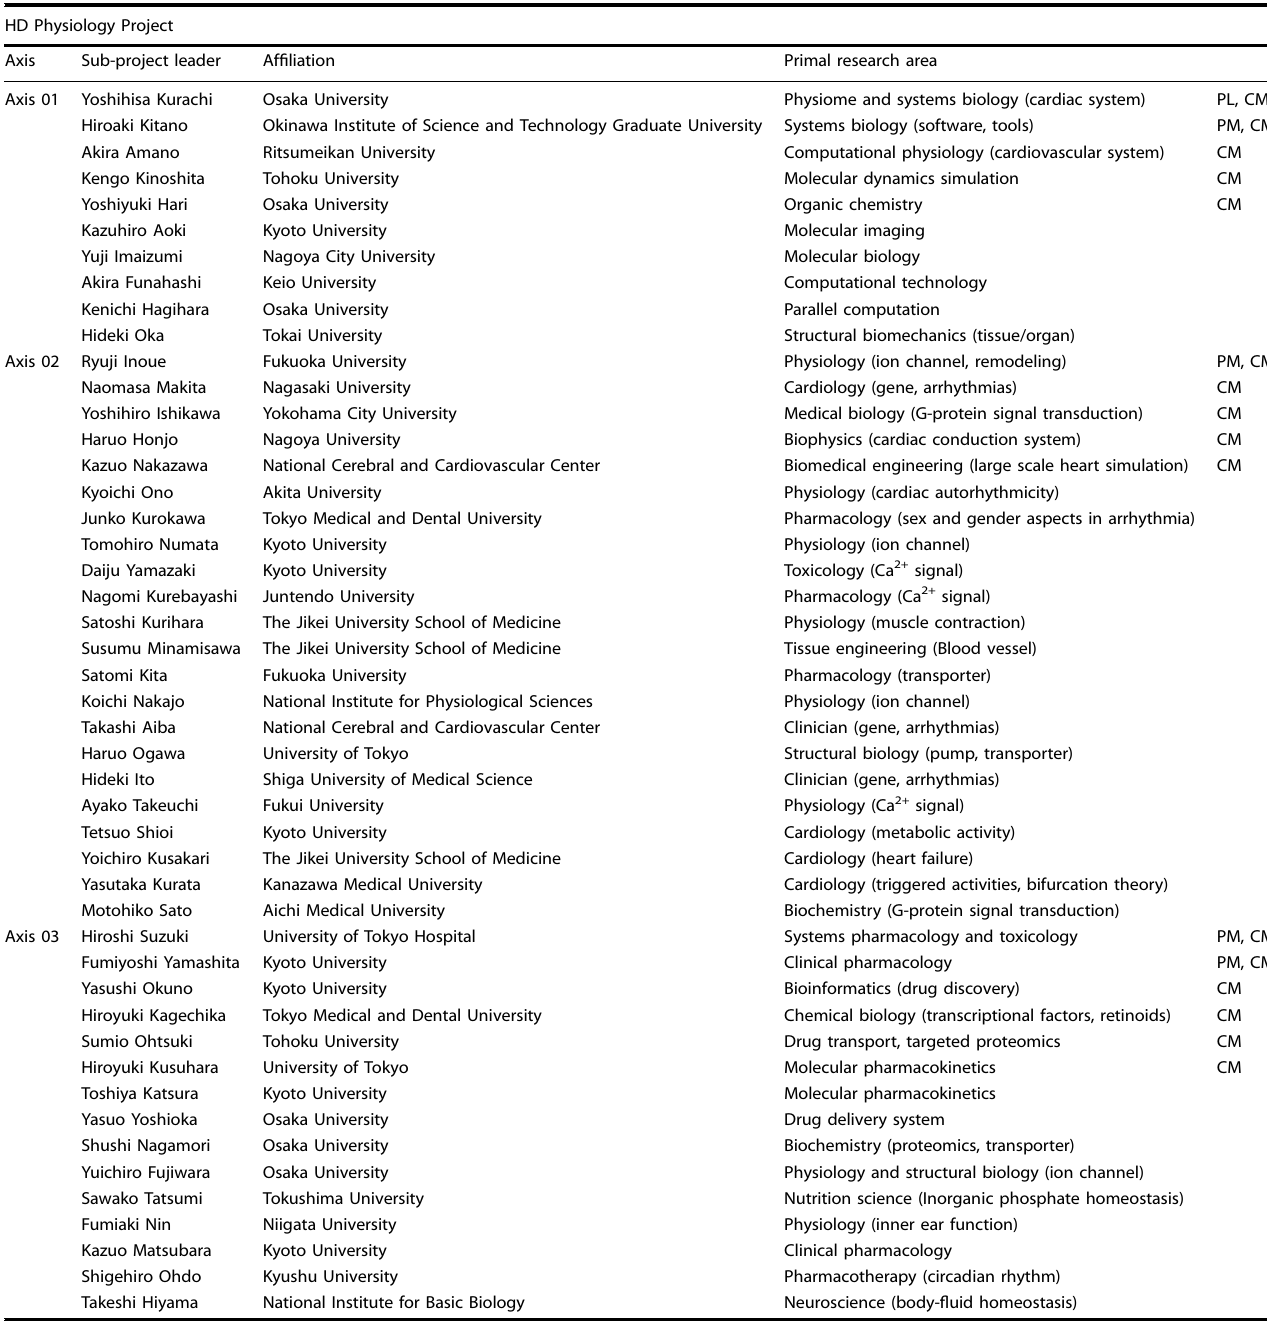
Table 1 HD Physiology Project member